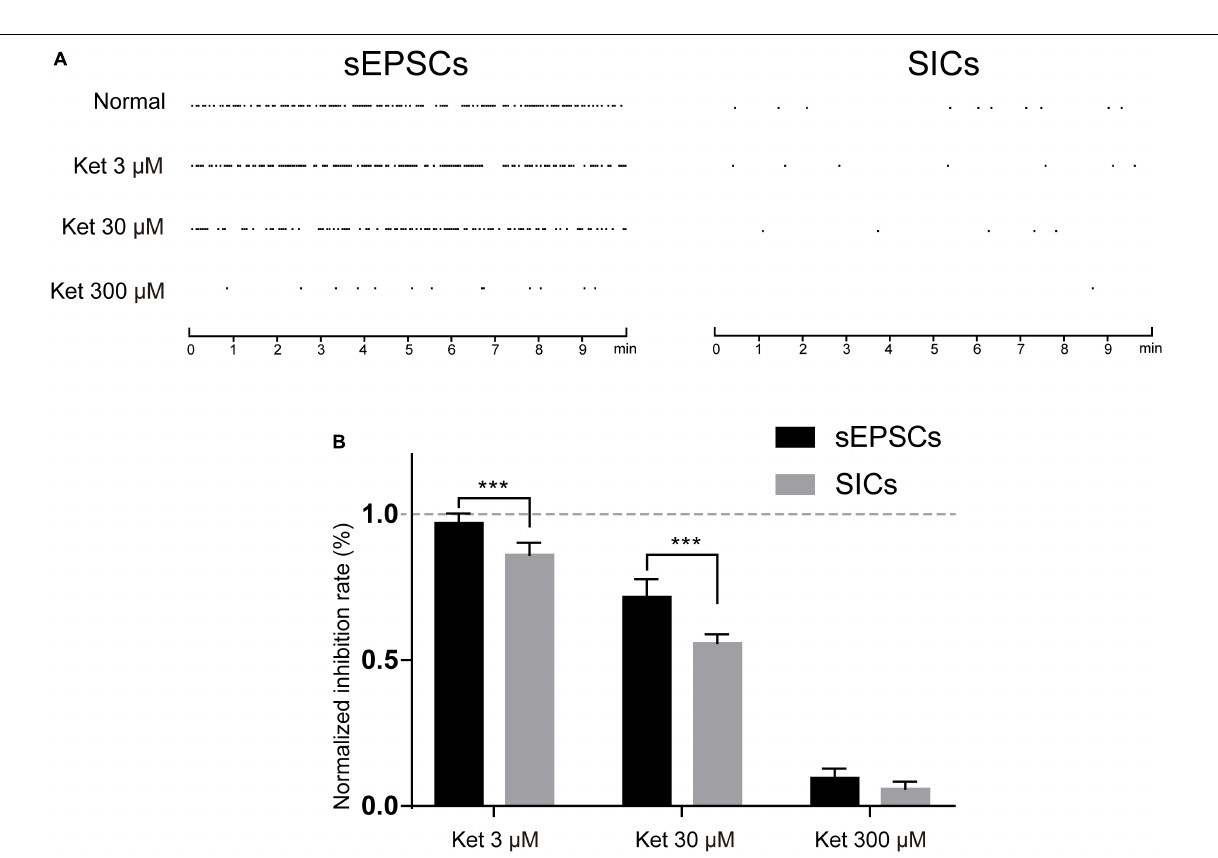
Frontiers in Cellular Neuroscience |